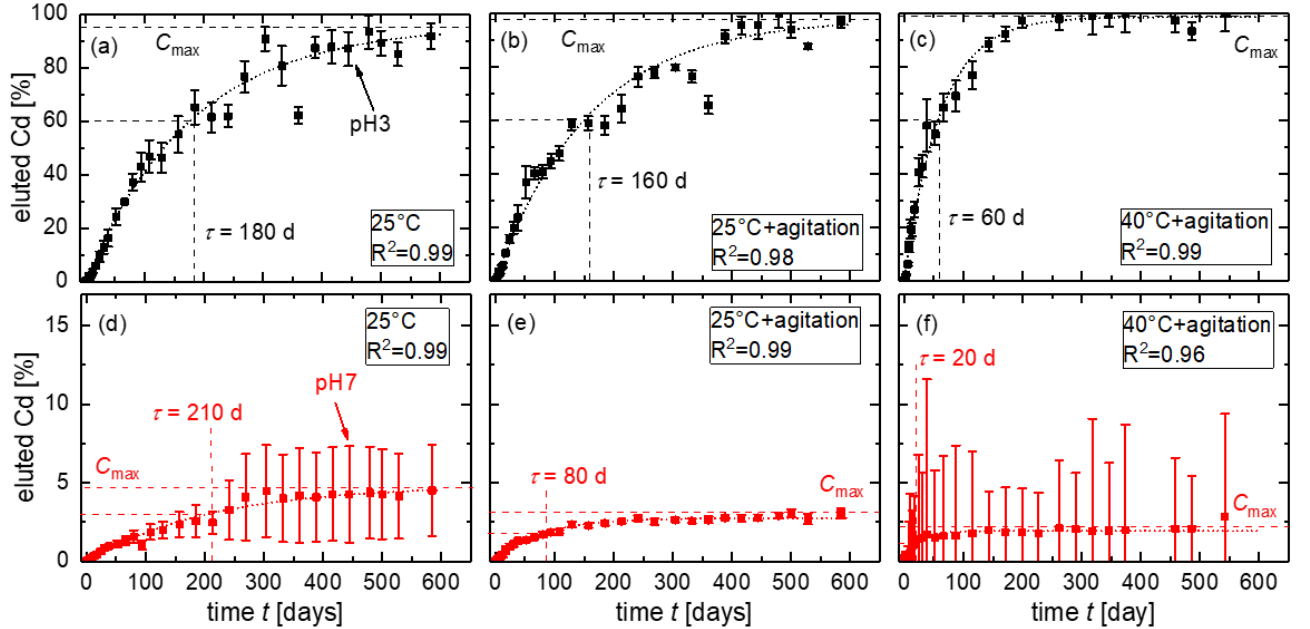
Figure 12. Leaching of Cd from CdTe module pieces in solutions with pH 3 at ( a ) T RT = 25 ◦ C, ( b ) at T RT = 25 ◦ C with agitation, and ( c ) at T IT = 40 ◦ C with agitation. Eluted Cd in solutions with pH 7 at ( d ) T RT = 25 ◦ C, ( e ) at T RT = 25 ◦ C with agitation, and ( f ) at T IT = 40 ◦ C with agitation. The dotted lines represent the calculated fit according to Equation (2) with high coefficients of determination R 2 . The dashed lines show the calculated maximum concentration C max in the